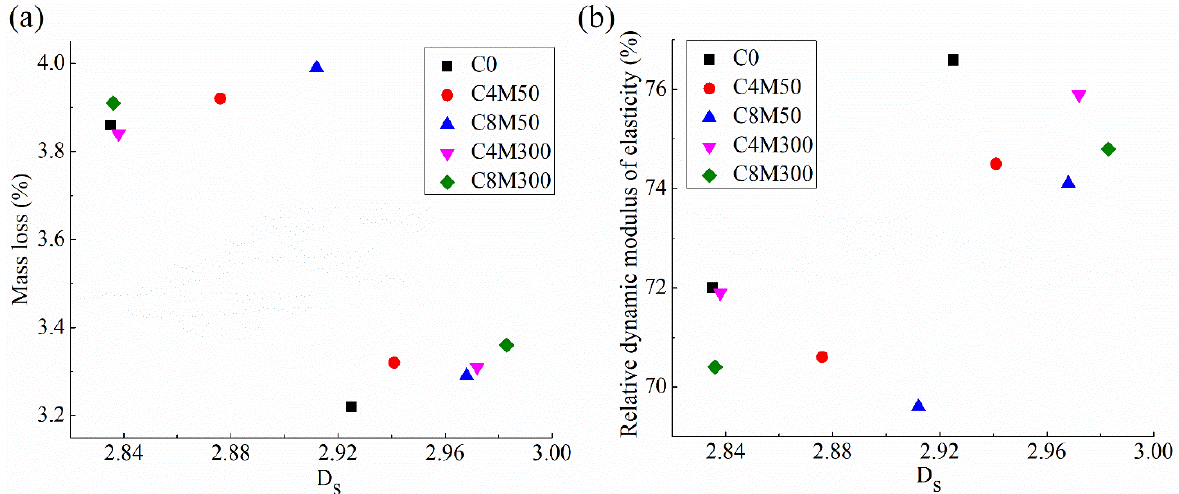
Figure 6. The correlation between D s and ( a ) mass loss and ( b ) relative dynamic elastic modulus of concrete.